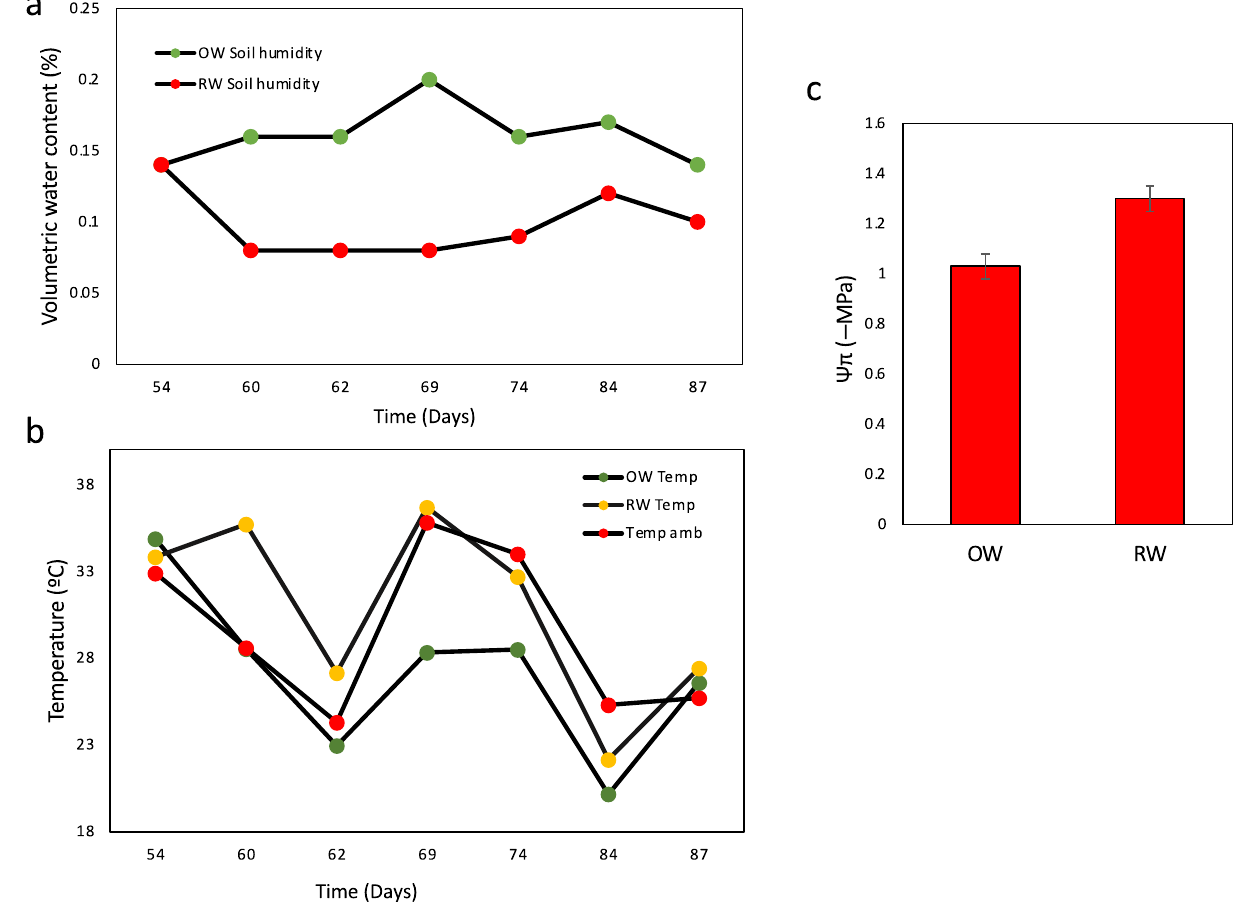
Figure 1. Water status and temperature conditions for the assay. ( a ) Soil water content evaluated over 33 days for two treatments, OW (green dot) and RW (red dot), at 54 DAS. ( b ) Environmental temperature (red dot) and leaf temperature for the OW treatment (green dot) and RW (yellow dot). ( c ) Osmotic potential in leaf under OW and RW at 60 DAS. Bars represent the mean of three biological replicates for each of nine landraces evaluated, while the error bars indicate the least significant differences (LSD) at p <